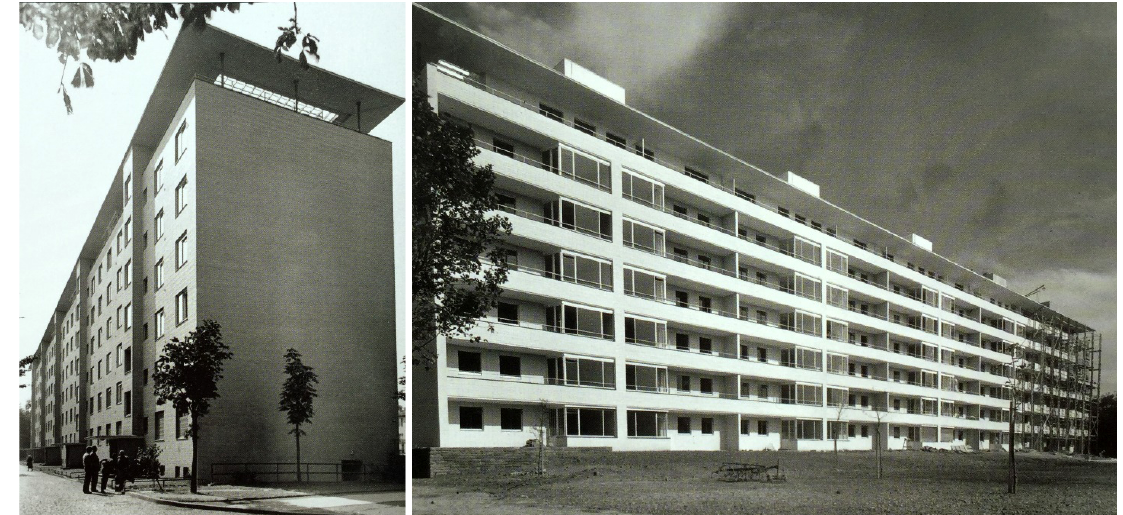
Figure 20. From left to right: W. Riphahn, Crew buildings, GAG Siedlungsbau Raderthal-Volkspark residential skyscraper, north-west view (“Besatzungsbauten, GAG Siedlungsbau Raderthal”, 1951); W. Riphahn, Residential skyscraper, west front view, 1951 (Konservator der Stadt Köln,